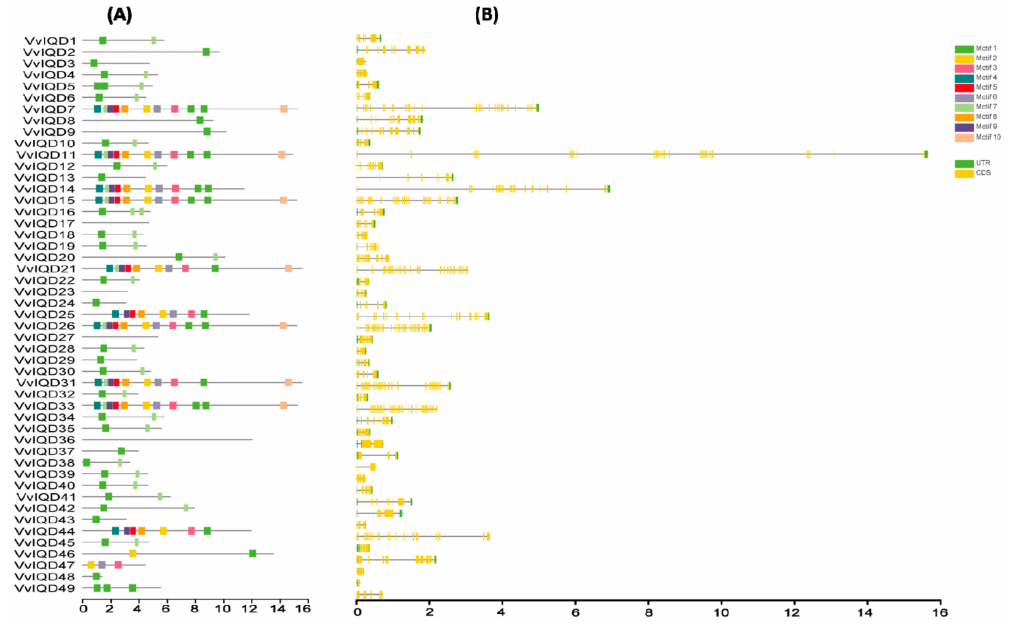
Figure 1. Motif structure of VvIQDs and gene structure analysis of IQD members in grapevine